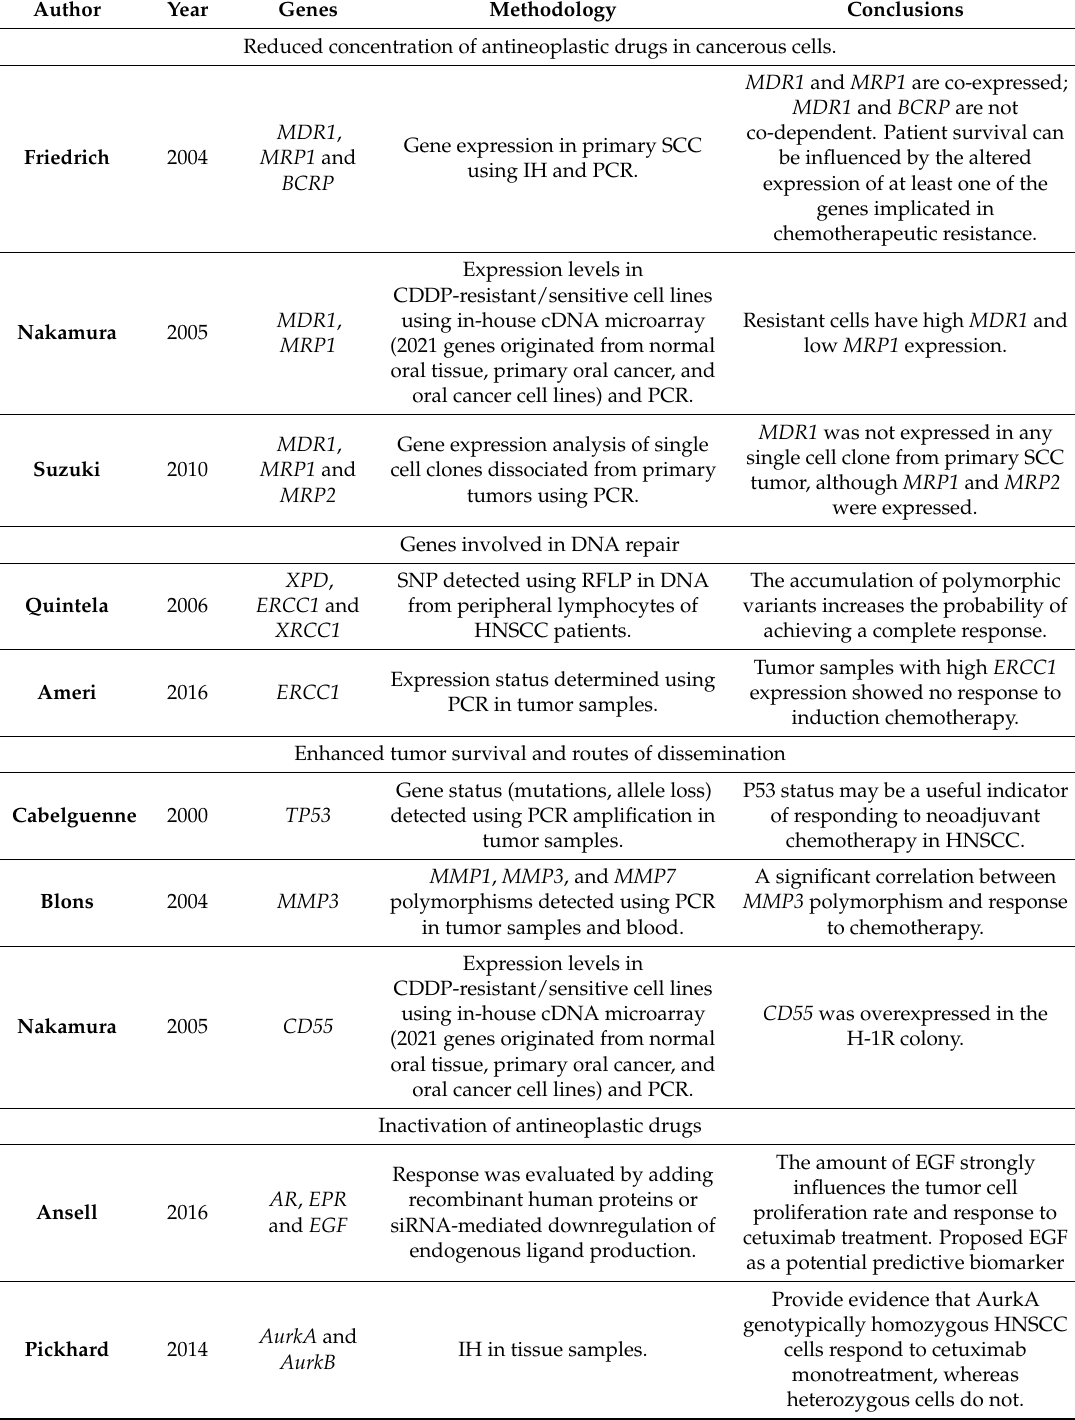
Table 1. The expression of molecular markers and their participation in multidrug resistance in head and neck squamous cell